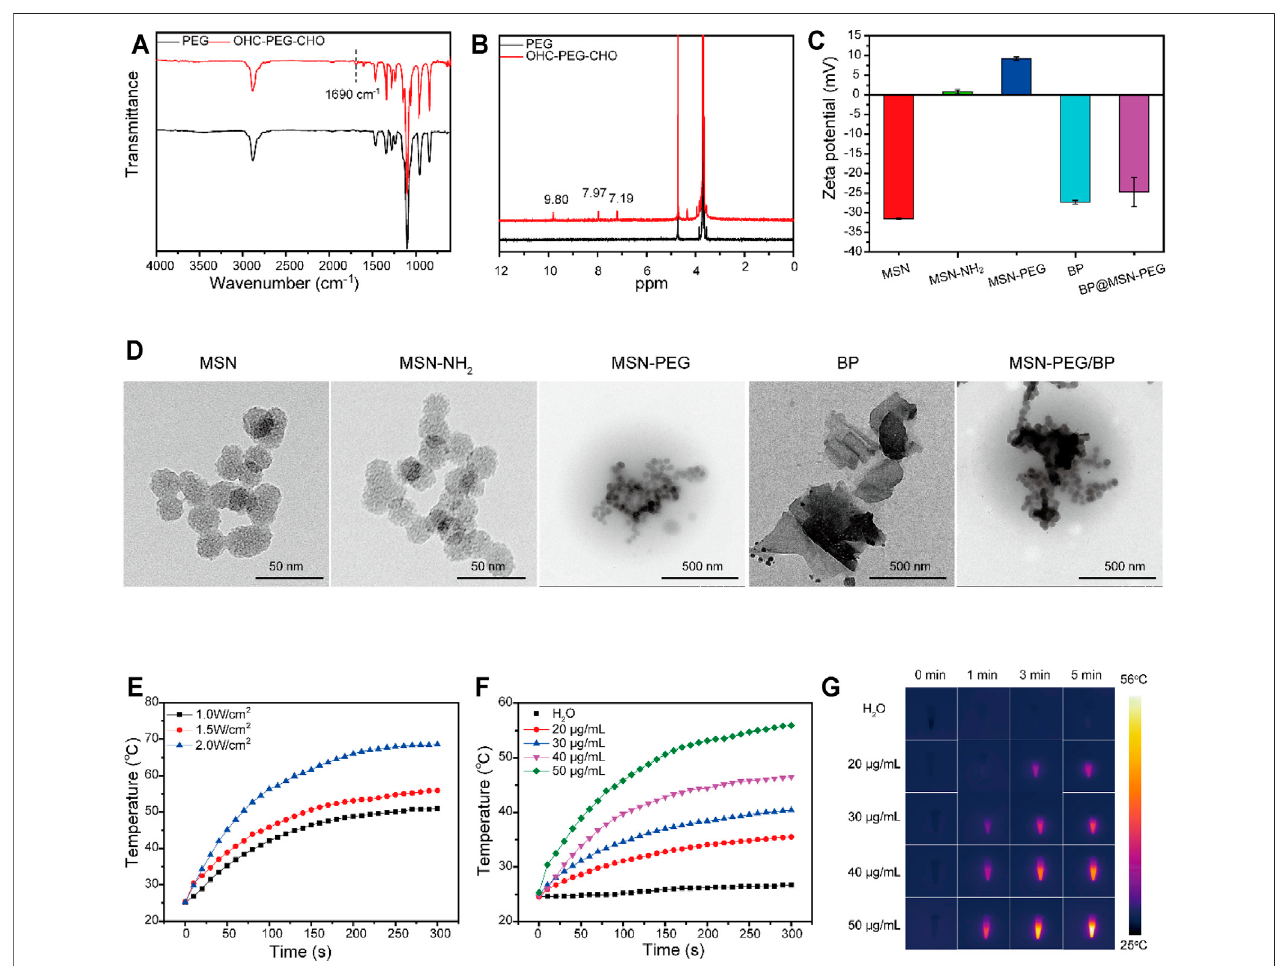
FIGURE 1 | Characterizations of AS@MSN-PEG/BP. (A) FTIR spectra of PEG and OHC-PEG-CHO. (B) 1 H NMR spectra of PEG and OHC-PEG-CHO. (C) Zeta potentialofMSN,MSN-NH2,MSN-PEG,BP,andMSN-PEG/BP. (D) TEMimageofMSN,MSN-NH2,MSN-PEG,BP,andMSN-PEG/BP. (E) Photothermaltemperature increase ofBPsolution(50 μ g/ml)under different NIR lightirradiation (0.5,1, 1.5, and 2 W/cm 2 ). (F) Photothermaltemperature increaseofDI waterand BPsolutionwith different concentrations (20, 30, 40 and 50 μ g/ml). (G) Photothermal imaging of DI water and BP solution with different concentrations (20, 30, 40, and 50 μ g/ml) under NIR light irradiation (1.5 W/cm 2 , 0 – 5